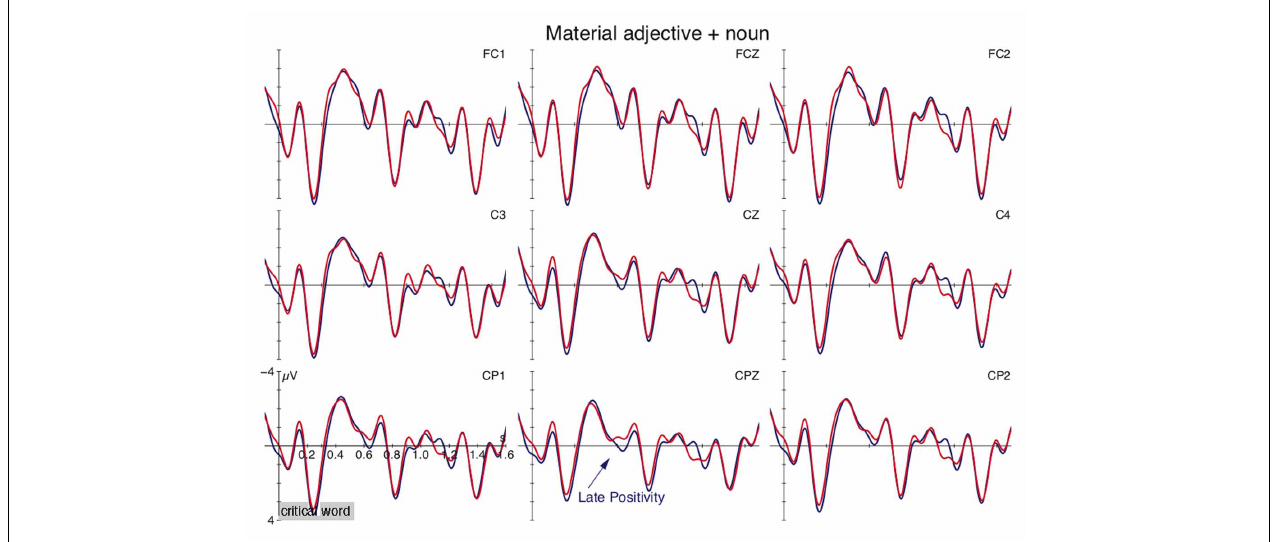
FIGURE 3 | Grand average ERPs for the adjective-noun combinations, time-locked to the noun (onset at vertical bar) at selected electrode sites for the meaning shift (blue) and control condition (red). Negativity is plotted